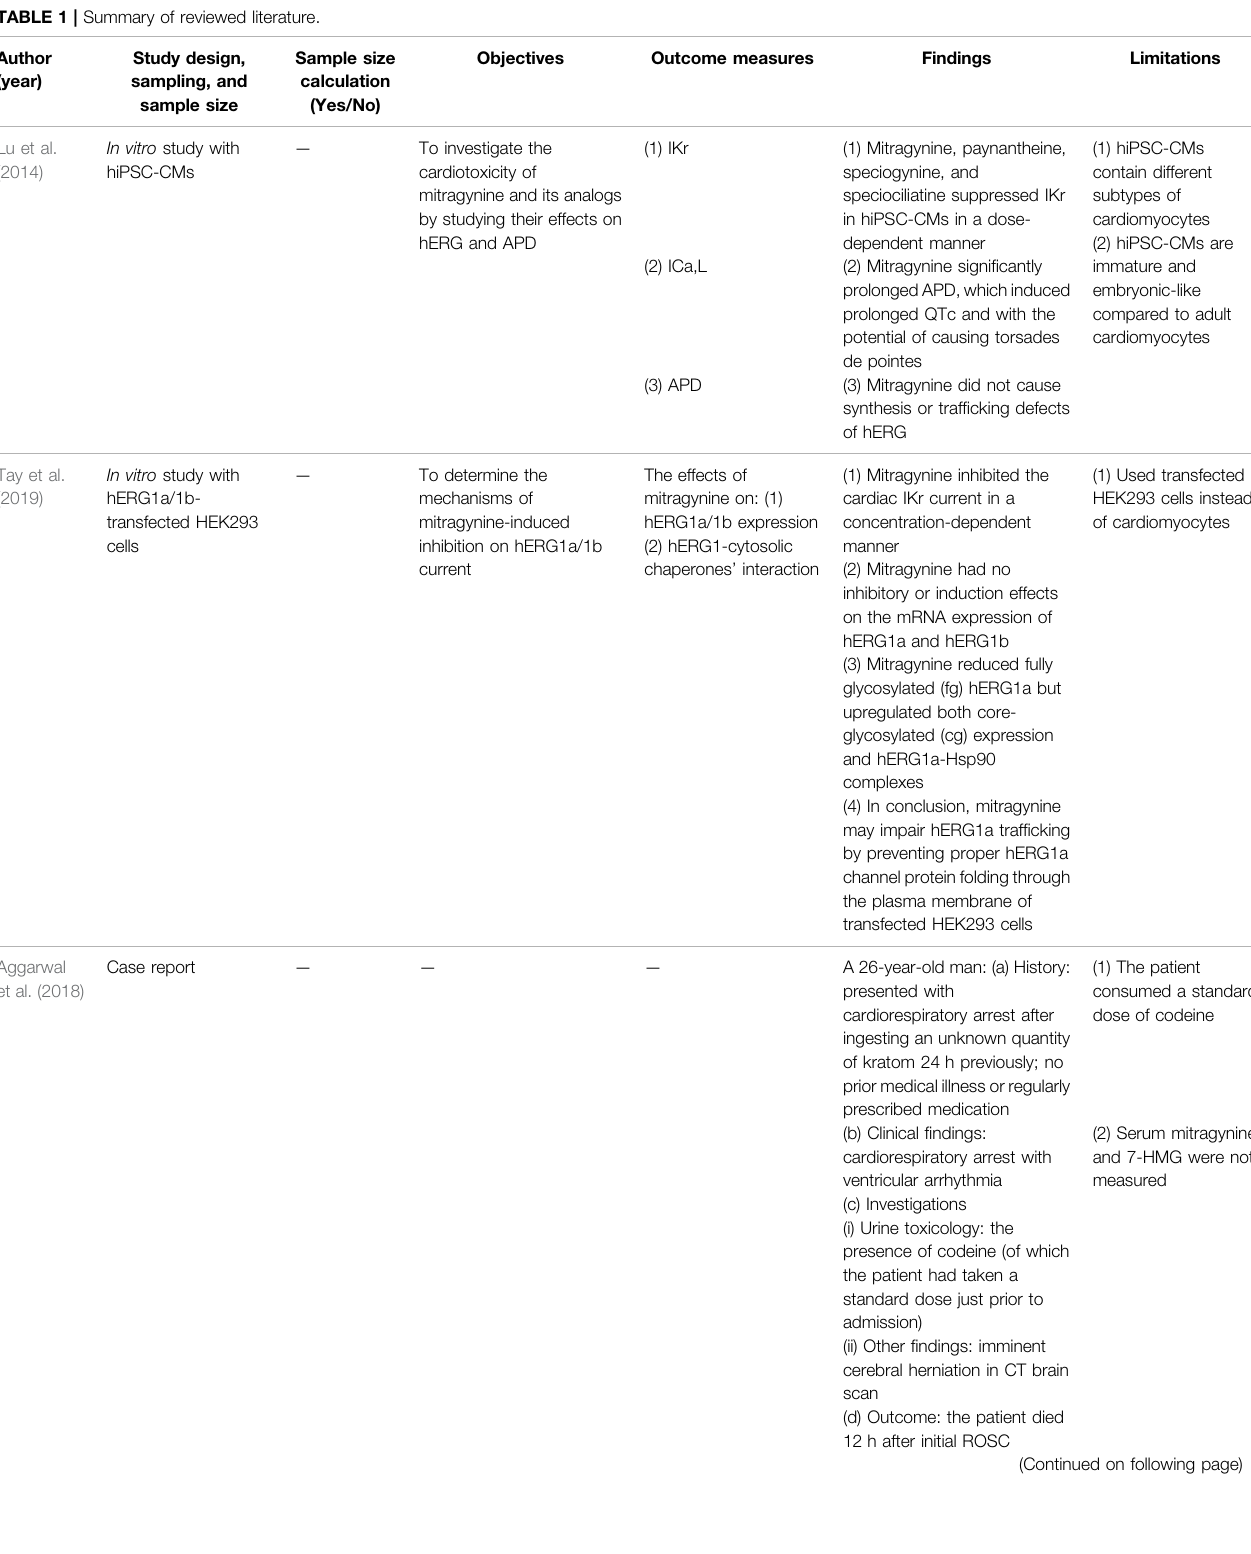
TABLE 1 | Summary of reviewed